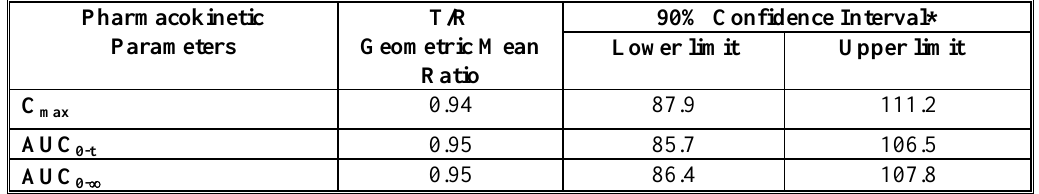
Table (5): Geometric mean ratio and 90% Confidence Interval for the pharmacokinetic Parameters of the test versus the reference products in fasting state .